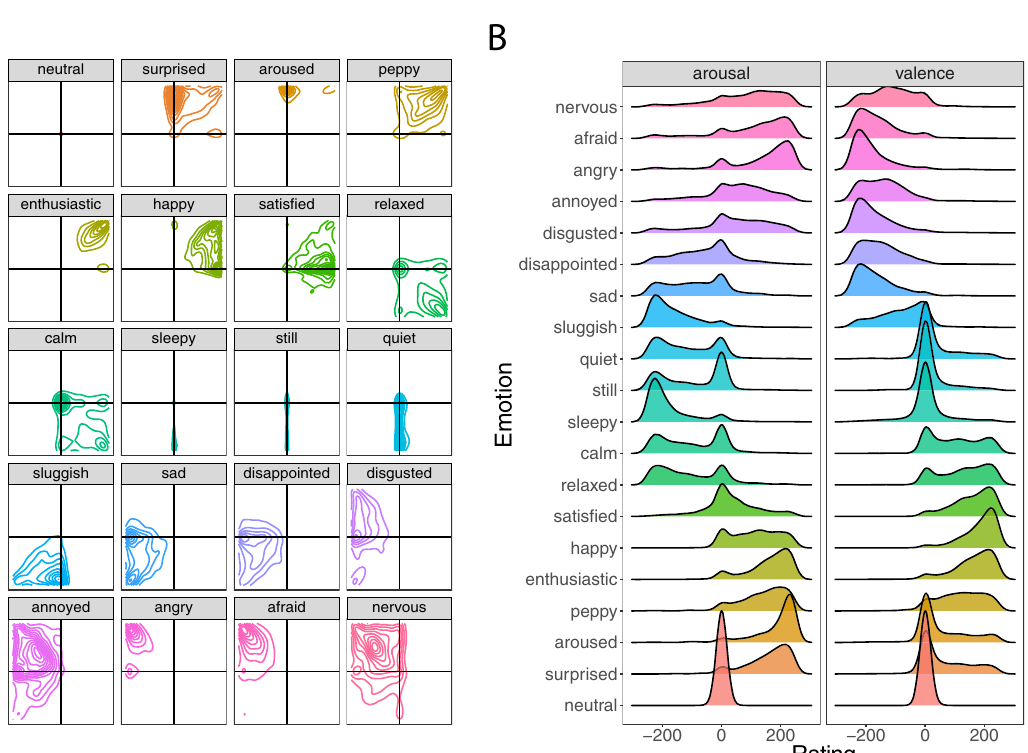
Fig. 3 Emotion classi fi cation plots. A Two-dimensional density plots of where participants ( N = 1491) placed each emotion term in the emotion classi fi cation task. The x-axis represents valence and the y-axis represents arousal. Contour lines illustrate different levels of density at the population level, see Supplementary Information for more detailed visualizations. B One-dimensional density plots illustrating the ratings of emotion terms in the emotion classi fi cation task, plotted separately for valence and arousal.